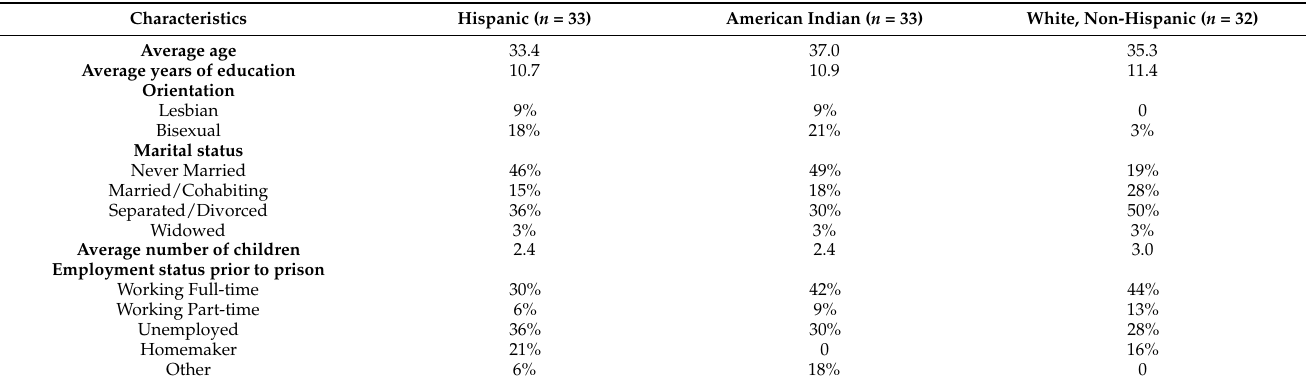
Table 2. Demographic information of participants by